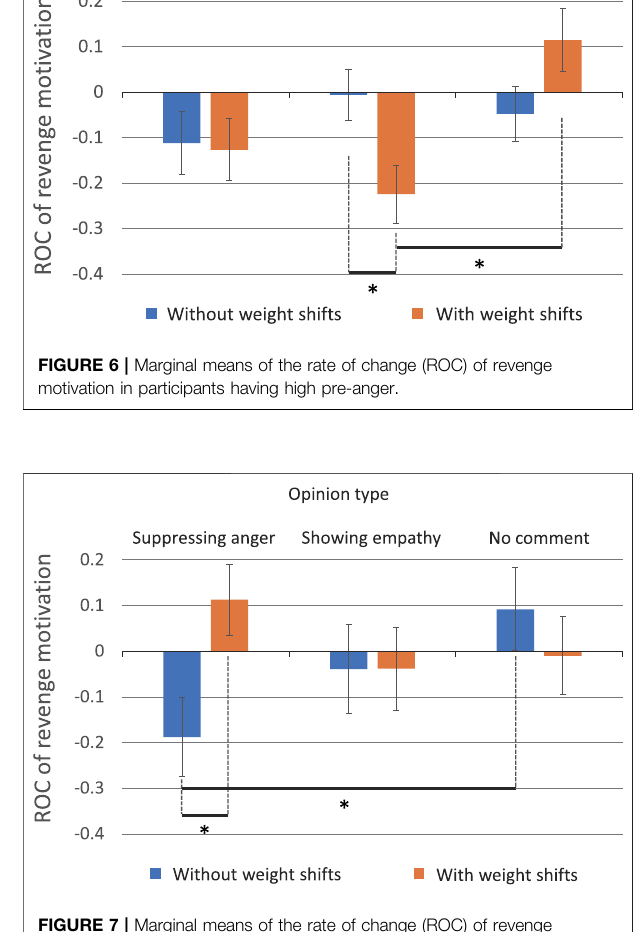
Frontiers in Robotics and AI |